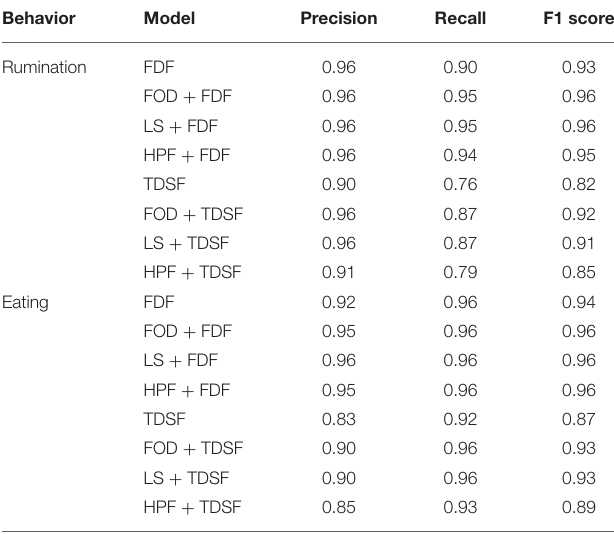
TABLE 6 | Precision, recall, and F1 score of rumination and eating behavior for every model. Behavior Model